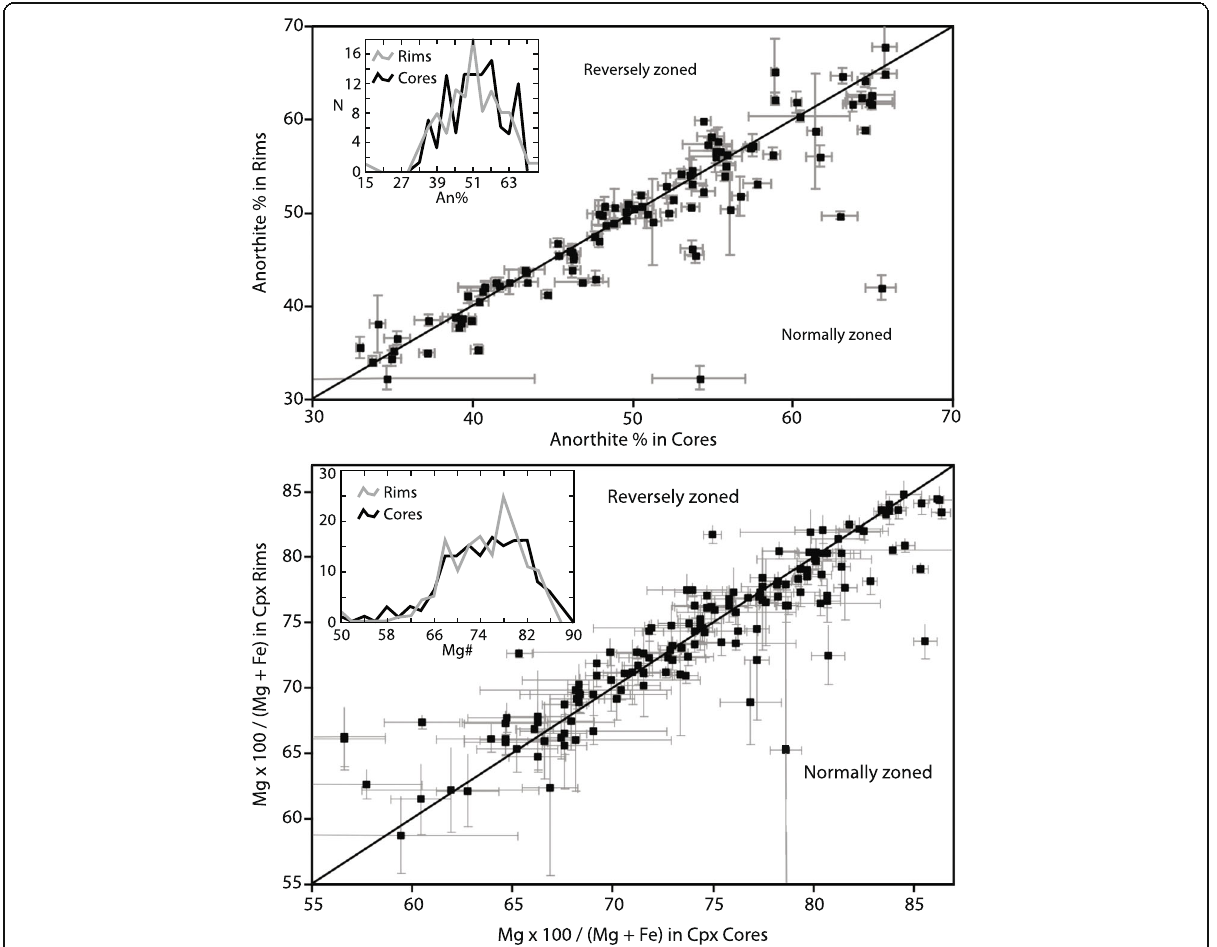
Fig. 11 a Compositions of plagioclase cores and rims from gabbros of this study plotted with the standard deviations for the analyses. Note that the distributions of core and rim analyses are nearly indistinguishable (inset plots). Line indicates 1:1 proportion. b Compositions of cores and rims of clinopyroxene from Hole 735B. The data are from Dick et al. (2001) and Angeloni and Dick (1990) (troctolite dikes from the upper 550 m of Hole 735B). The solid black line indicates 1:1 proportion. The core-rim information is not generally available for the upper 550 m of Hole